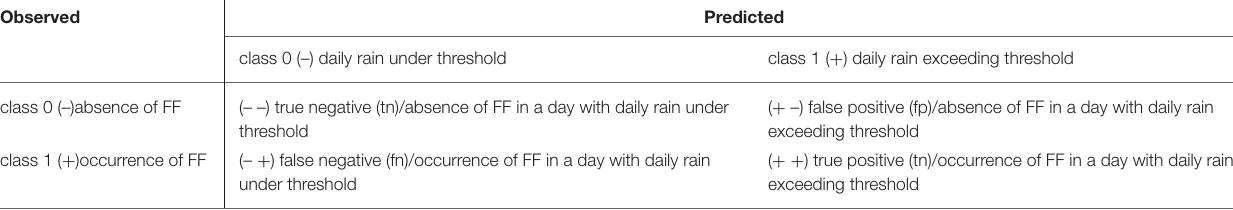
TABLE 3 | Contingency table used for flash flood model evaluation (modified after Frattini et al., 2010). Observed Predicted